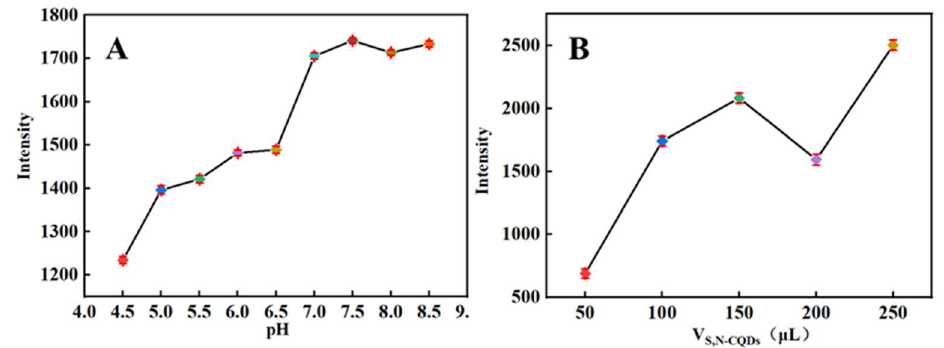
Figure 4. ( A ) Fluorescence response of S, N−CQDs at pH values from 4.5 to 8.5 in the presence of 50 μmol/L MTX; ( B ) fluorescence response of S, N−CQDs at dosage values from 50 to 250 μL in the presence of 50 μmol/L MTX.